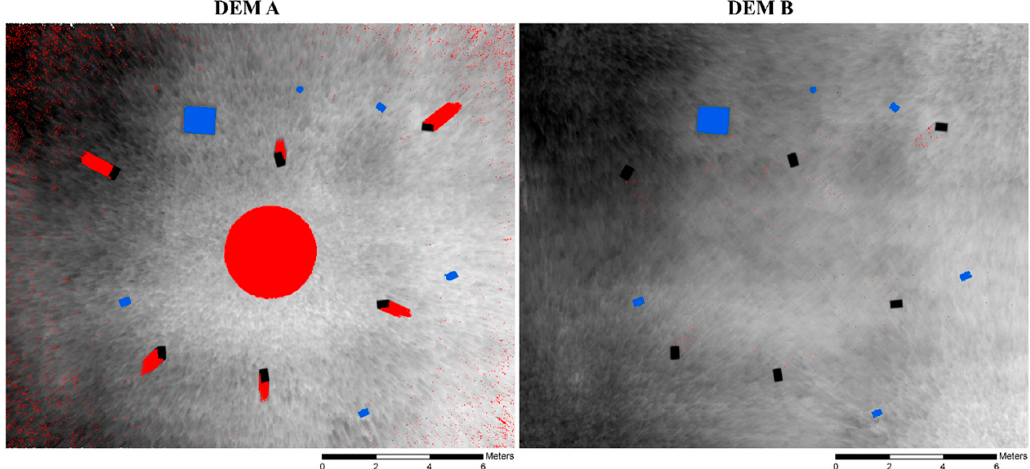
Figure 9. Data gap classification results for test site DEM A and DEM B. The DEMs are colored using a grayscale color ramp (black is higher elevation). Areas in red represent occlusions and dropouts are colored blue. Locations of the cardboard boxes are colored black. Table 1. Results of data gap classification for test site DEMs A and B.